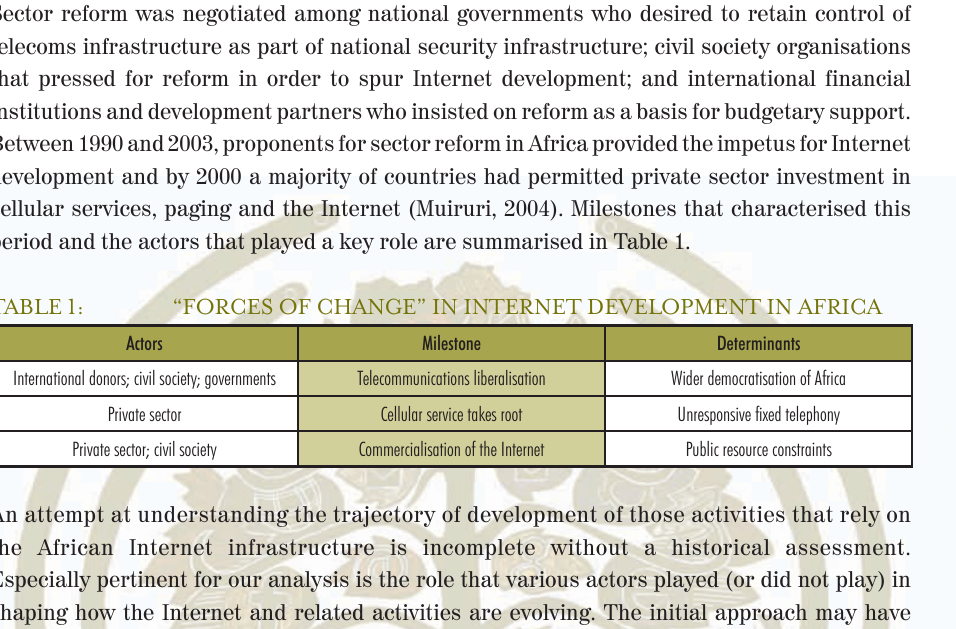
Public resource